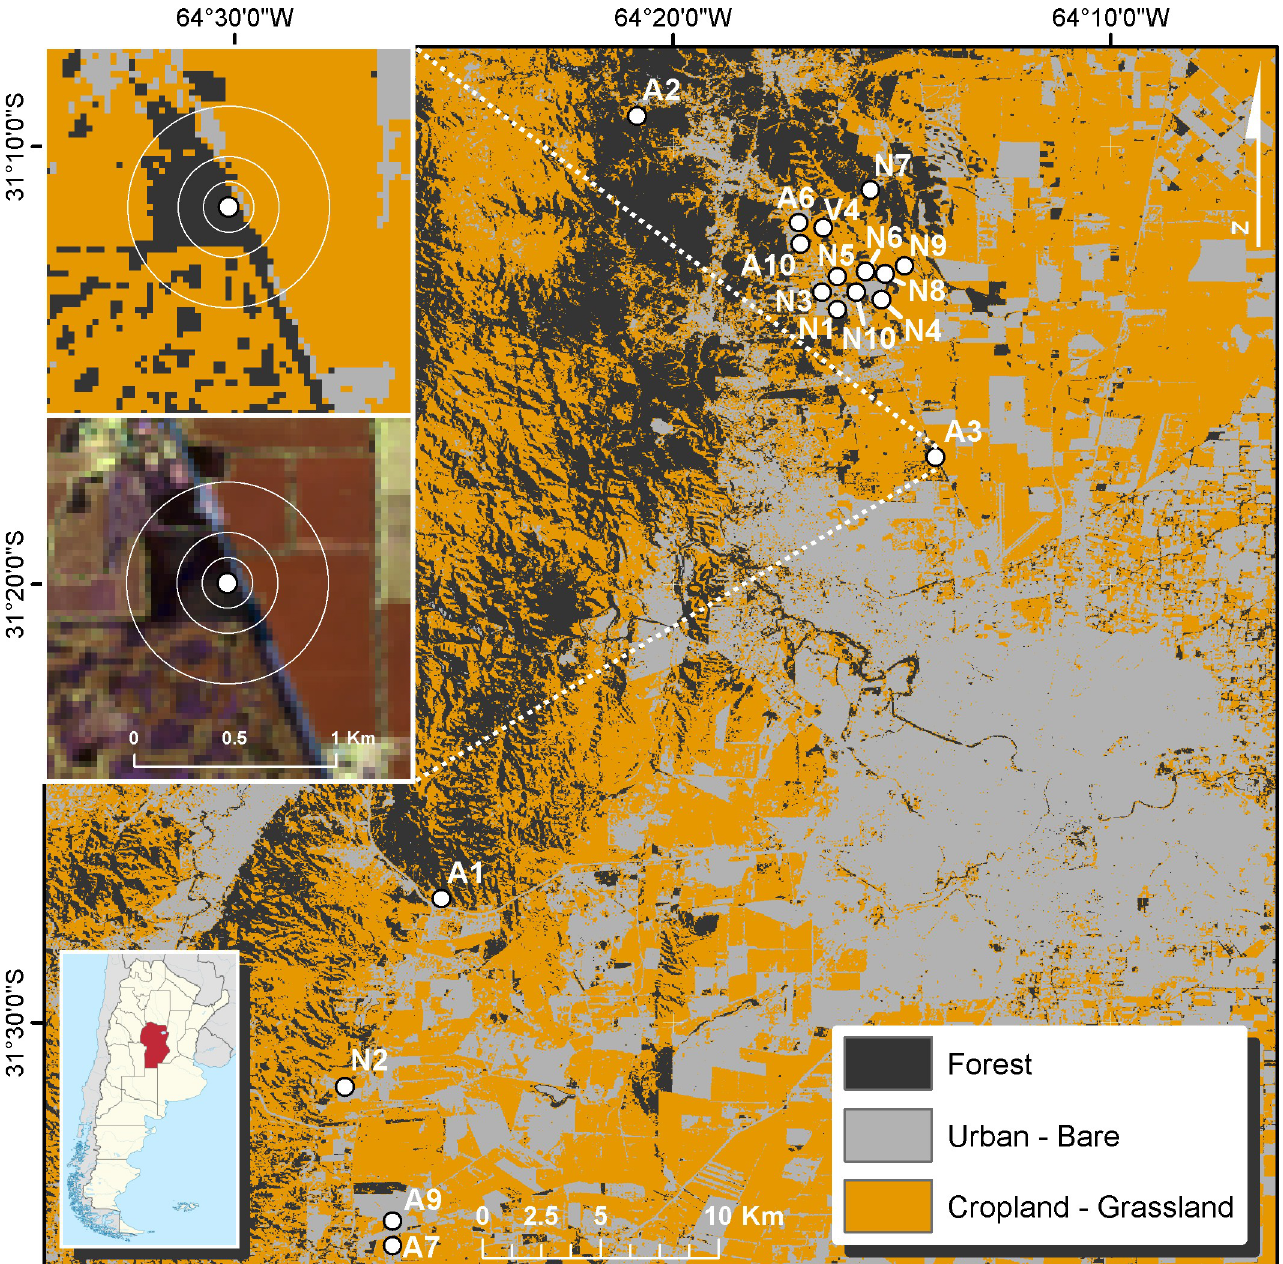
Fig 1. Map of the study sites. The map is showing 18 Chaco Serrano forest fragments resurveyed in 2013. We show the expanded view of a single forest patch with the three buffer distances of 250, 500 and 1000m used to calculate the percent change in forest cover after a decade with land-cover classifications using LANDSAT